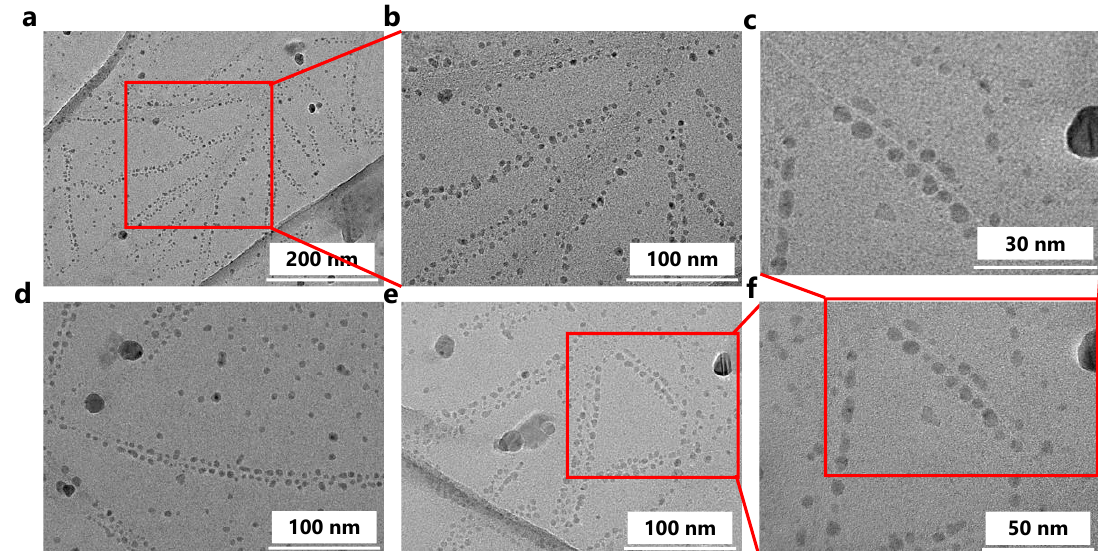
Figure 8. ( a - f ) Typical HR-TEM images (with different resolution) of porphyrin polymer molecules (marked with AuNPs) on SWNT surfaces, in which the polymer molecules align in the form of a coplanar well-ordered regular repeated array rather than wrapping along the tube surface.